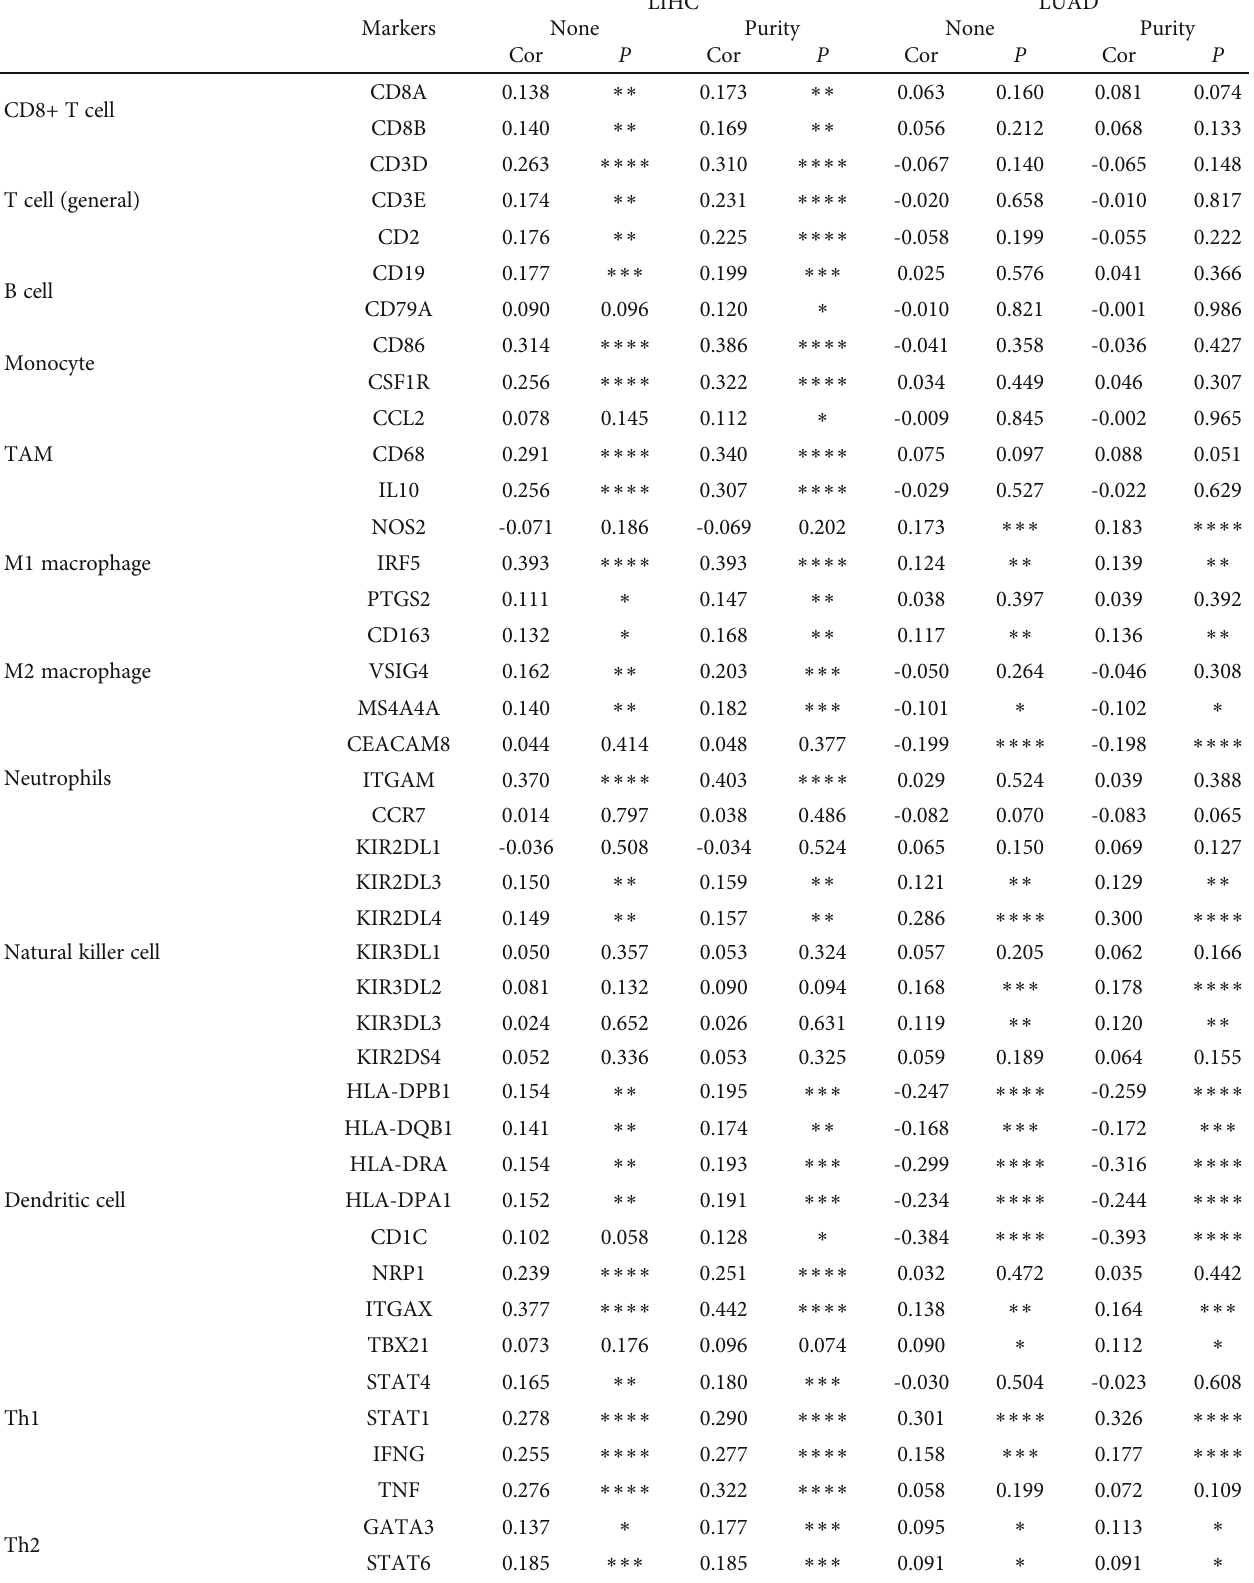
Table 3: Correlation analysis between DHX37 and related genes and markers of immune cells in